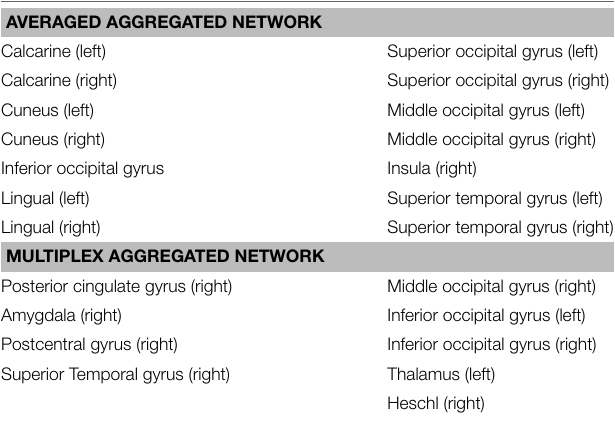
TABLE 1 | ROIs with connectivity differences from DTI at 1.2 standard deviation. AVERAGED AGGREGATED NETWORK Calcarine (left) Superior occipital gyrus (left) Calcarine (right) Superior occipital gyrus (right) Cuneus (left) Middle occipital gyrus (left) Cuneus (right) Middle occipital gyrus (right) Inferior occipital gyrus Insula (right) Lingual (left) Superior temporal gyrus (left) Lingual (right) Superior temporal gyrus (right) MULTIPLEX AGGREGATED NETWORK Posterior cingulate gyrus (right) Middle occipital gyrus (right) Amygdala (right) Inferior occipital gyrus (left) Postcentral gyrus (right) Inferior occipital gyrus (right) Superior Temporal gyrus (right) Thalamus (left) Heschl